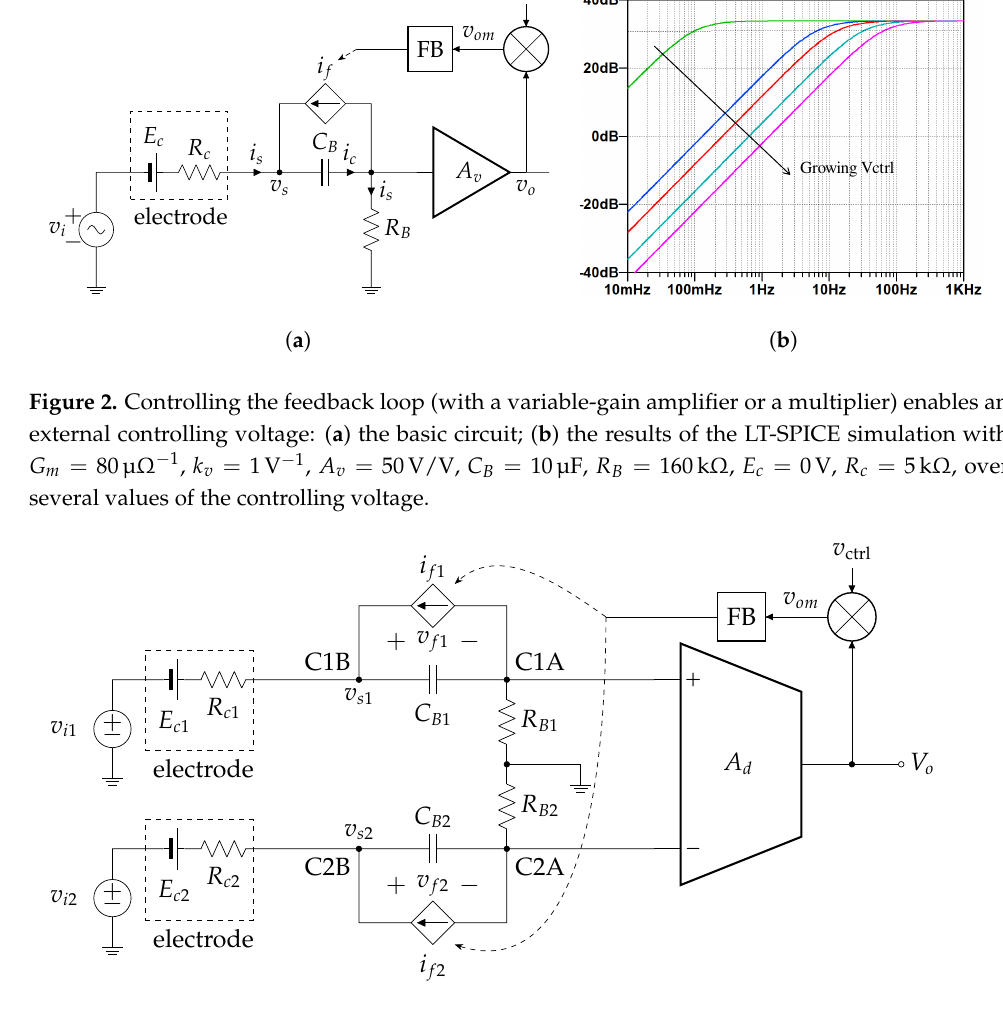
Figure 3. Simplified schematic diagram of the differential